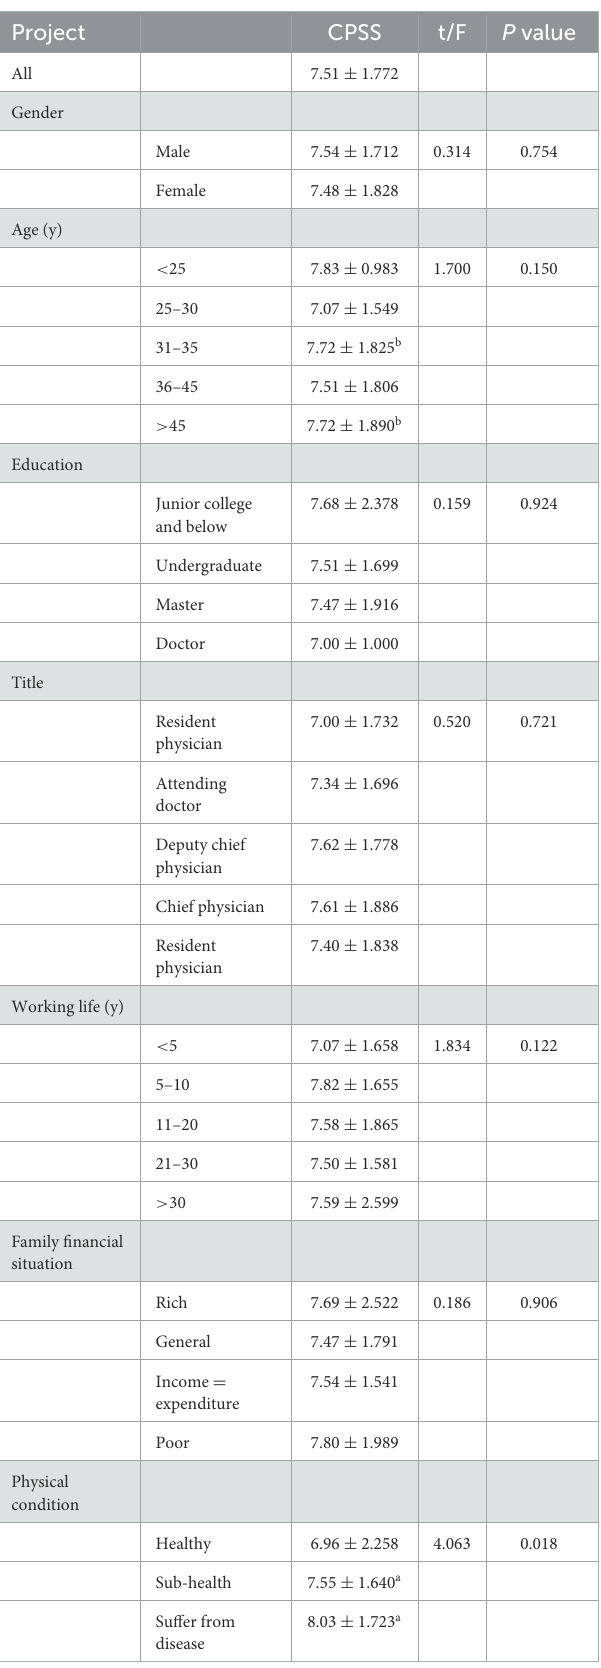
TABLE 3 Score of job stress ( ¯ x ±